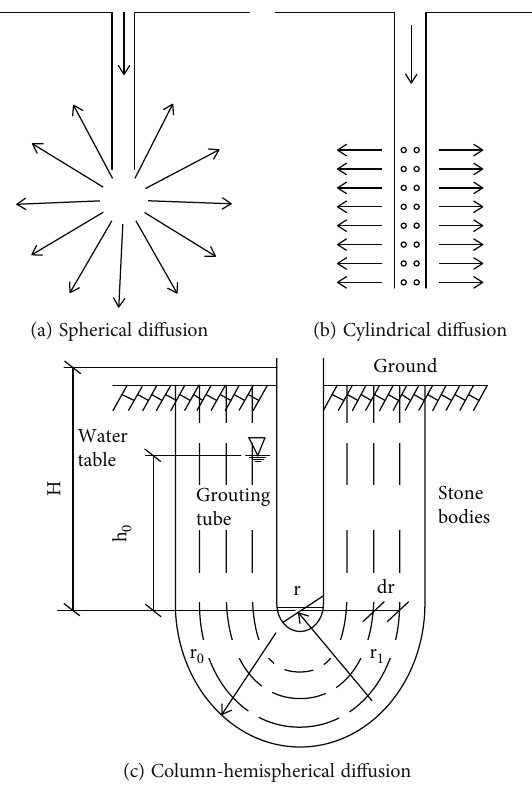
Figure 2: Slurry di ff usion modes.